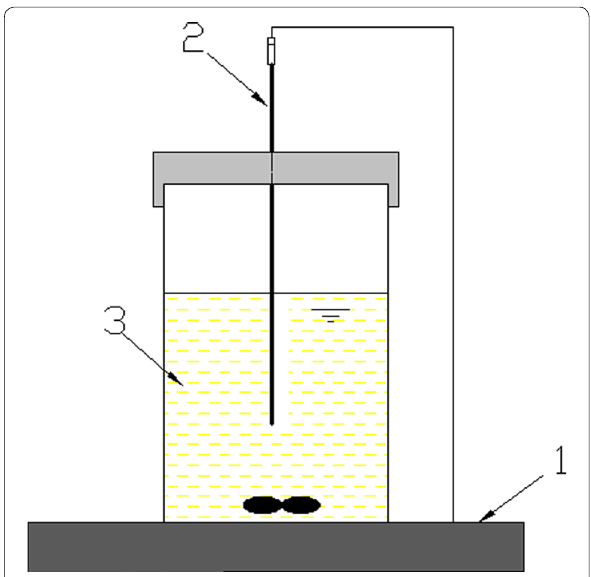
Fig. 2 Experimental apparatus: (1) magnetic stirrer; (2) temperature probe; (3) bacteria